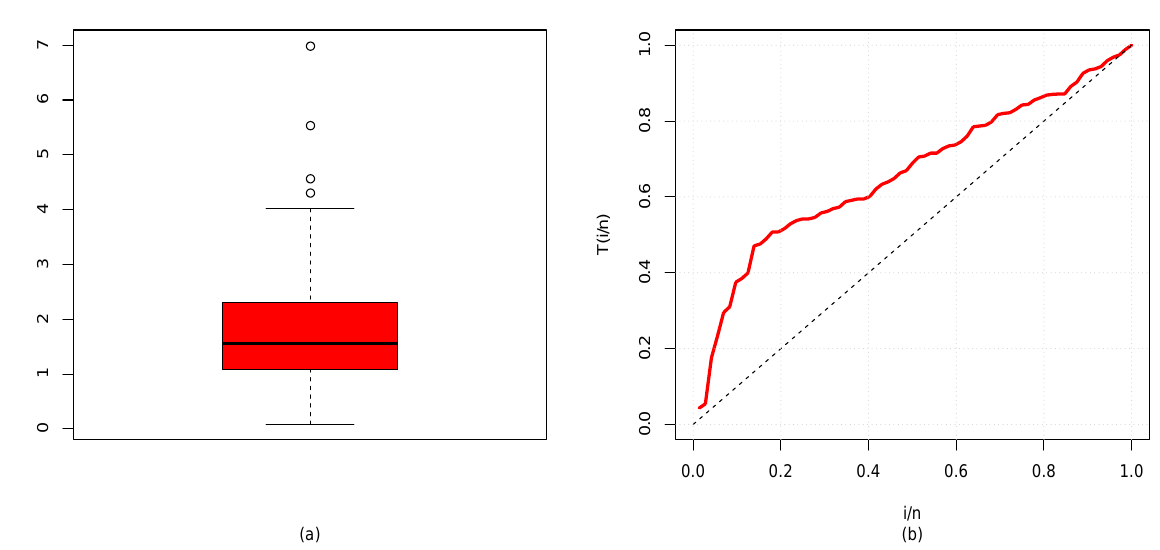
Figure 7. ( a ) Box plot and ( b ) TTT plot for GP data.